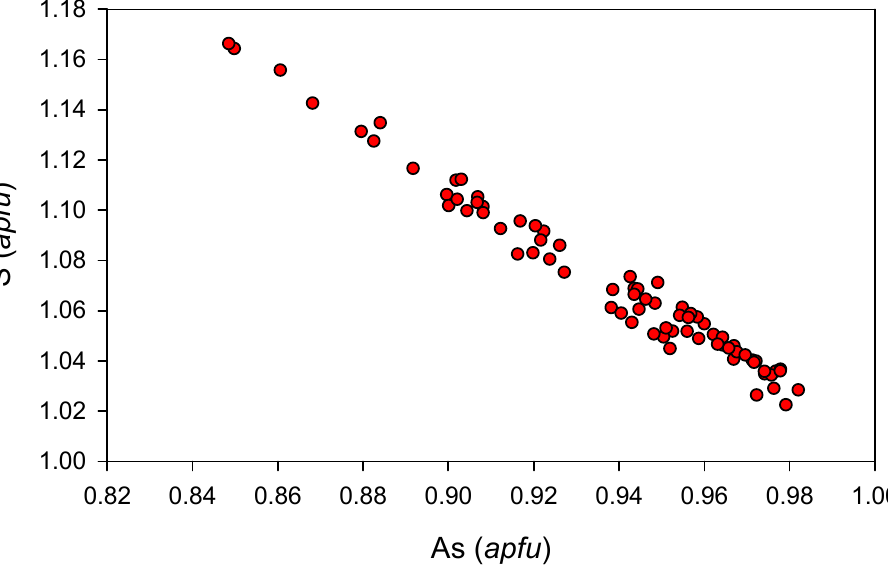
Figure 9. Compositional variation of zonal arsenopyrite in an As versus S ( apfu ) plot. The chemical composition of galena is close to the ideal formula (Table S2); only traces of Ag (up to 0.004 apfu ), Sb (up to 0.012 apfu ), and Bi (up to 0.004 apfu ) were determined; the measured contents of Fe (up to 1.49 wt. %) probably come from the surrounding pyrite. Pyrite is stoichiometric without the other elements, including As. Sphalerite shows varying chemical composition (Table S3); the most abundant minor elements are Fe, Cd, Mn, and Cu. Iron and cadmium are always present with contents up to 0.06 and 0.003 apfu , respectively; their contents positively correlate. The presence of Mn and Cu is irregular and does not reach 0.005 apfu . The chemical composition of chalcopyrite (Table S4) corresponds to the ideal formula with traces of Mn and Pb; part of its grains contains